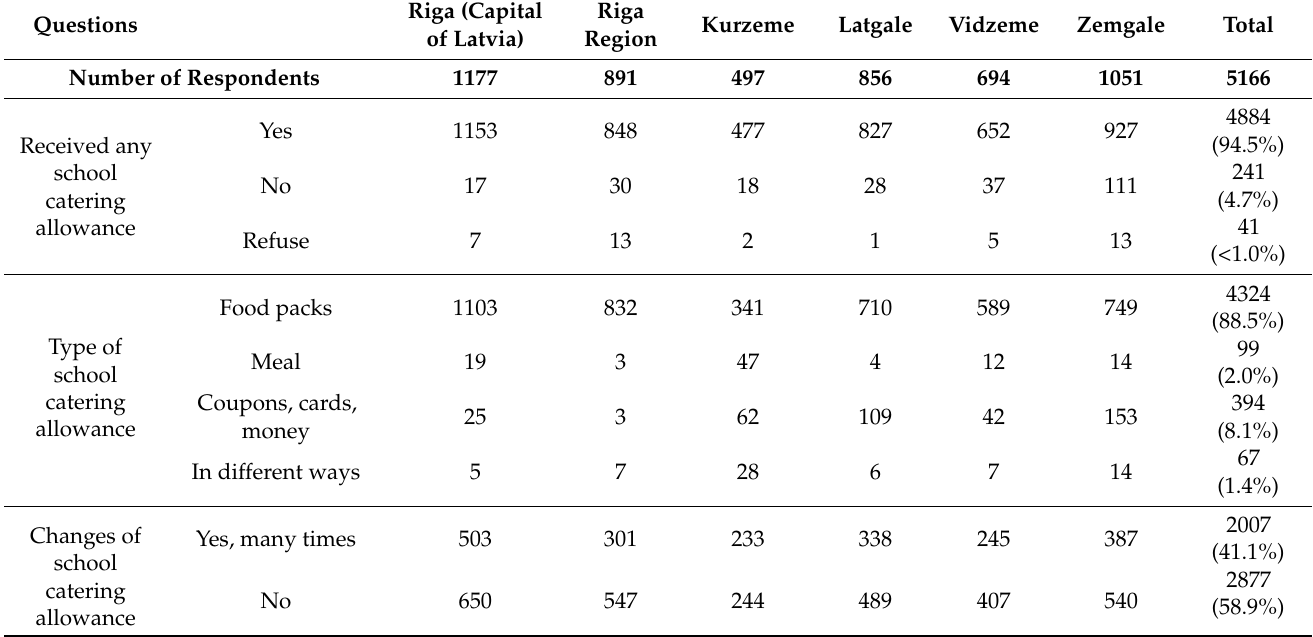
Table 2. Characteristics of the received school catering allowance by regions of